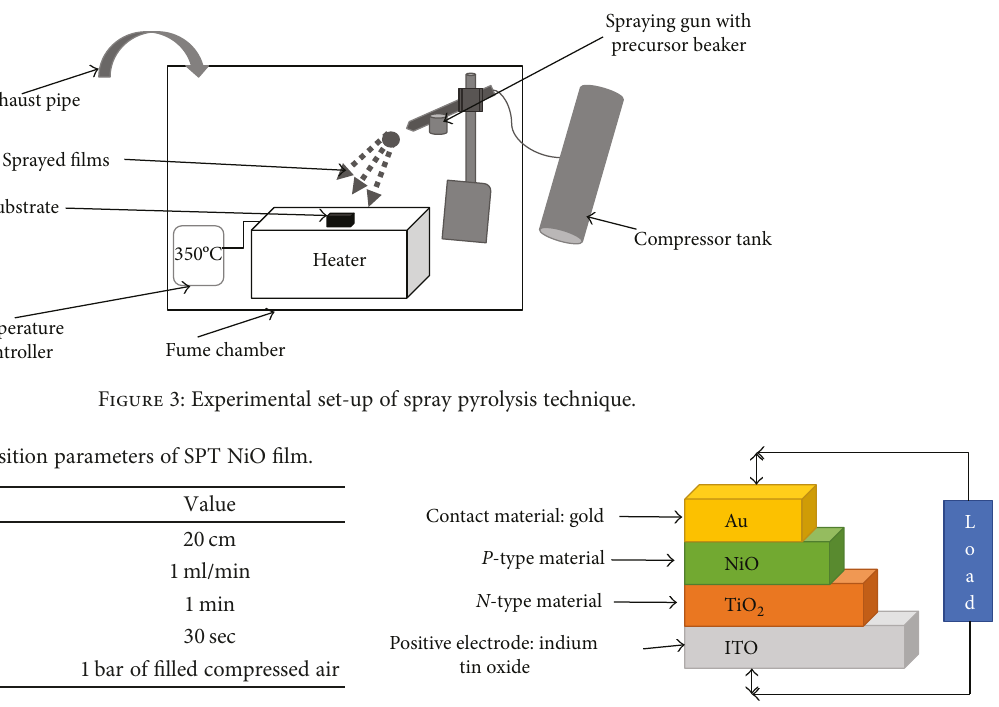
Figure 4: Schematic of the fabricated NiO/TiO solar